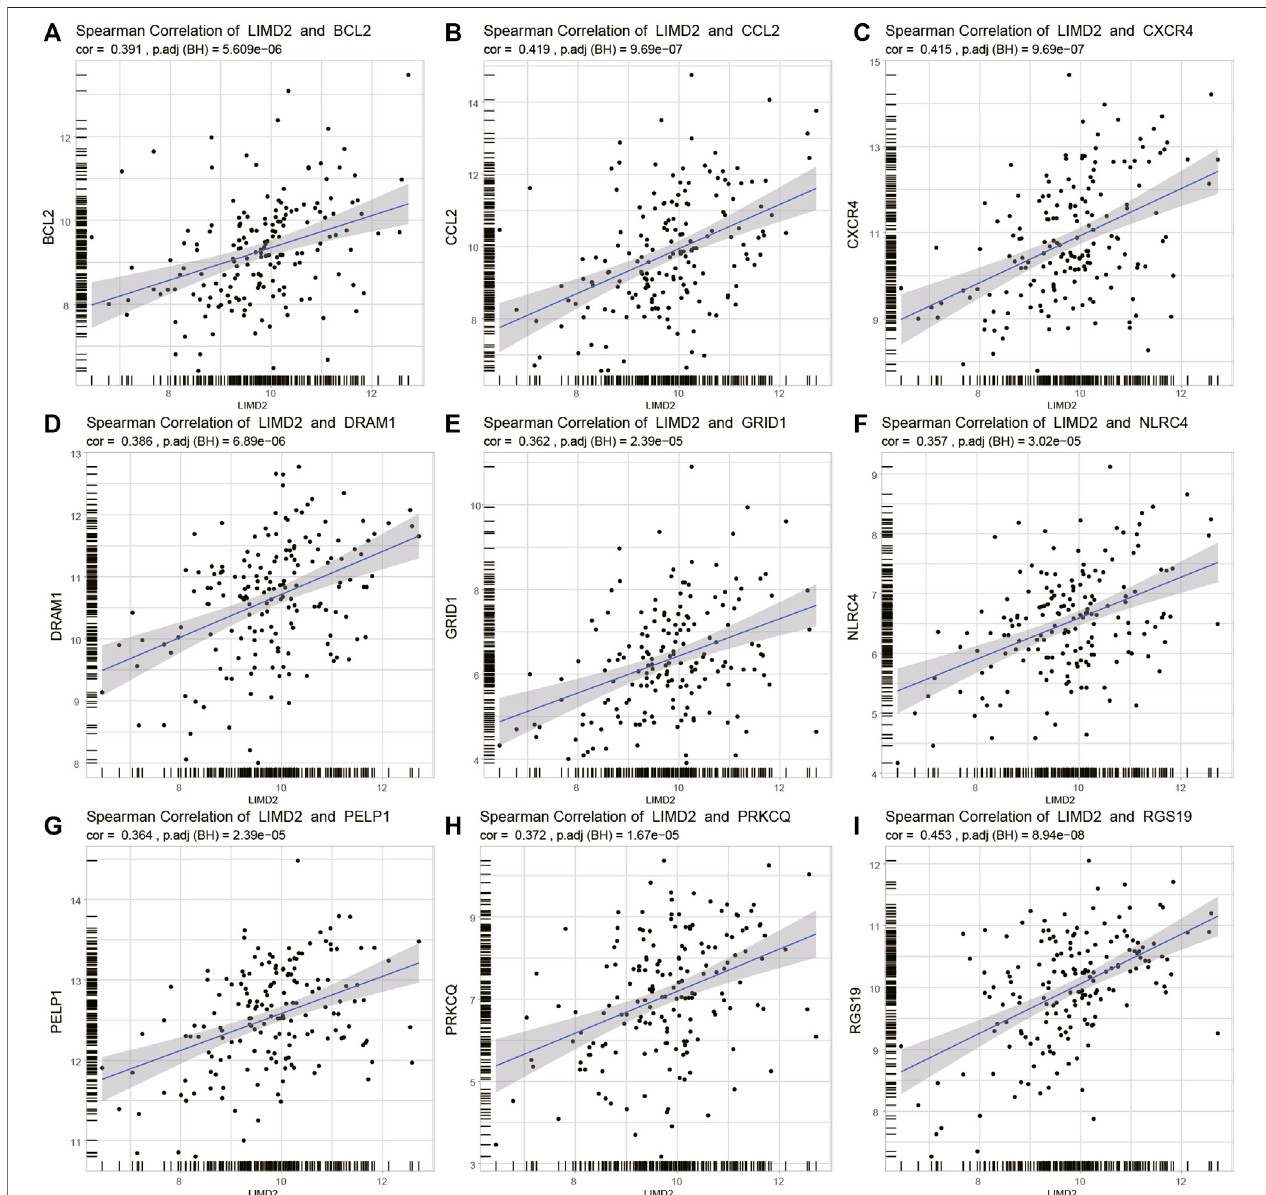
FIGURE 7 | Plots showing Spearman ’ s correlation of LIMD2 and autophagy-related genes in TCGA cohort. In every plot, the X-axis represents LIMD2 and the Y-axis represents autophagy-related genes. (A – I) Spearman ’ s correlation of LIMD2 and BCL-2 (A) , CCL2 (B) , CXCR4 (C) , DRAM1 (D) , GRID1 (E) , NLRC4 (F) , PELP1 (G) , PRKCQ (H) , and RGS19 (I) . Dashed line in each plot is the regression